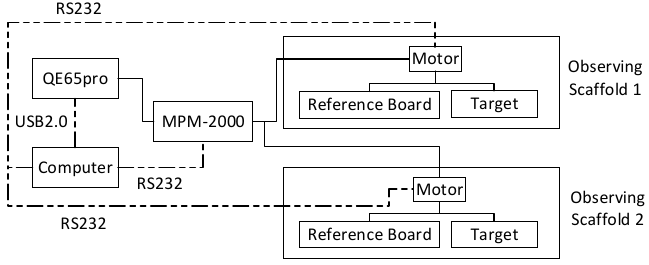
Figure 1. The structure of the automatic observation system .